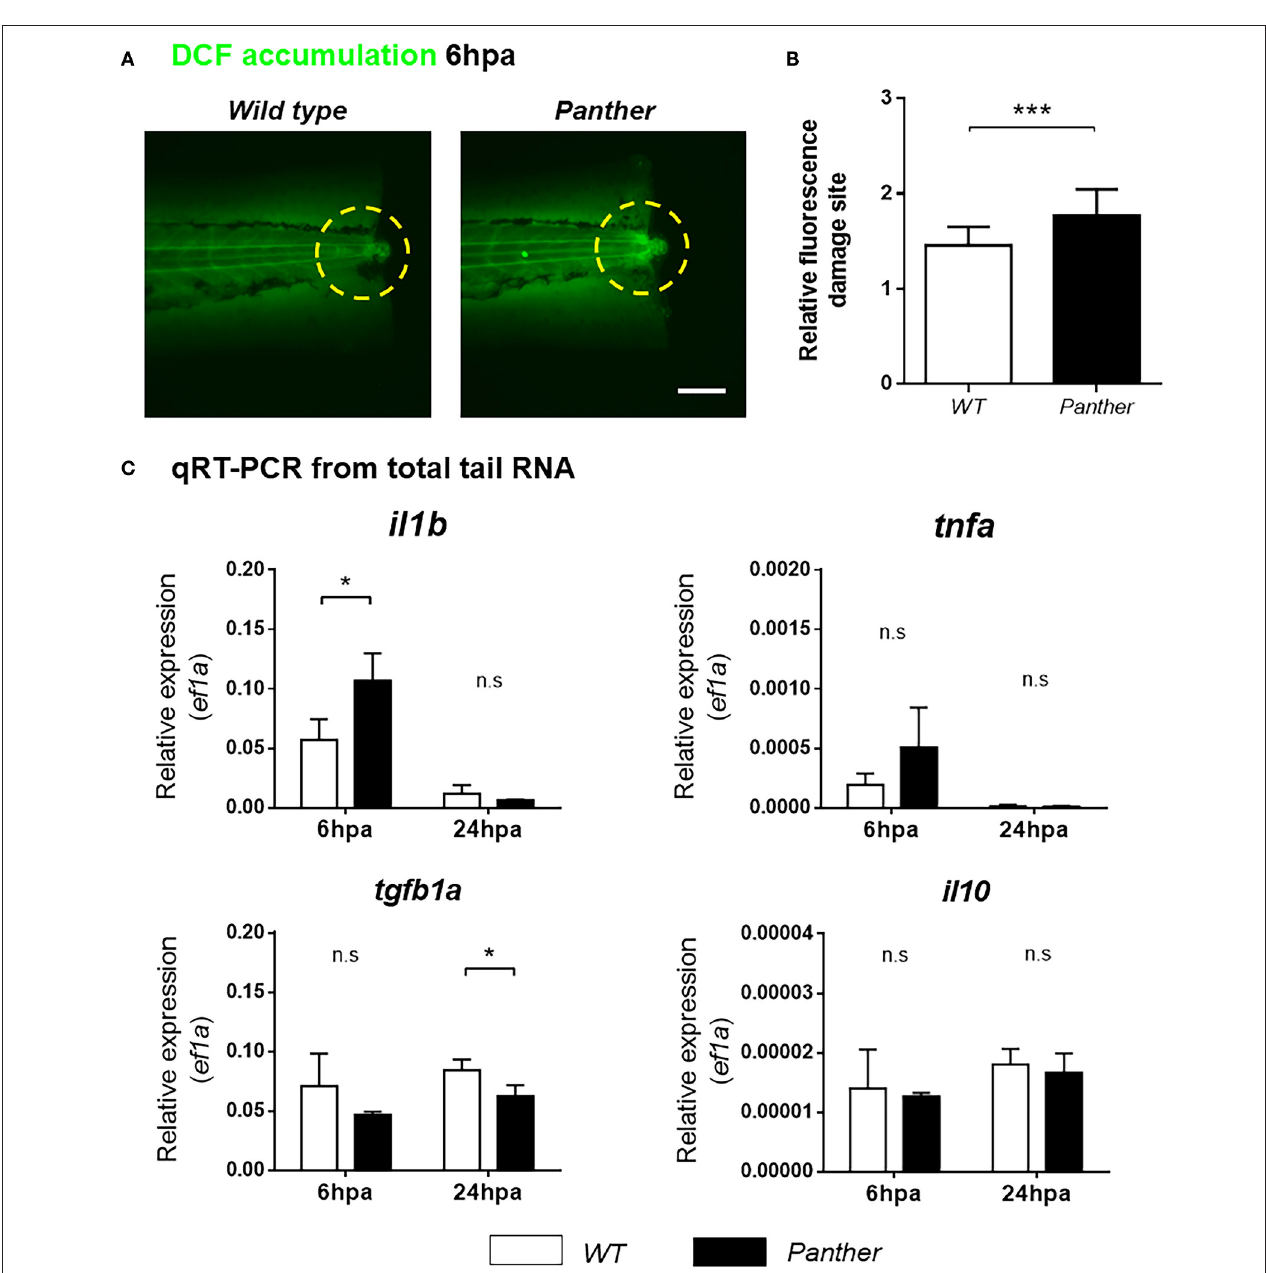
FIGURE 6 | Heightened il1b expression and ROS in the damage site of panther larvae after tail fin amputation. (A) The amount of ROS generated in the damage site (yellow dashed circle) was measured through the accumulation of the fluorescent 2 ′ 7 ′ -dichlorofluorescein (DCF) sensor. Scale bar = 100 µ m. (B) Relative fluorescence in the damage site ± SD of panther and wild type larvae. Twenty larvae per condition were analyzed. (C) Quantitative RT-PCR for il1b , tnfa , tgfb1a, and il10 from tails of panther and WT larvae at 6 and 24 hpa. The expression of ef1a was used as housekeeping for the 2 − 1 Ct calculation. A pool of ∼ 20 larval tails was collected for RNA isolation, and the graphs show the mean ± SD of three independent experiments per condition. n.s not significant; * p < 0.05; *** p <